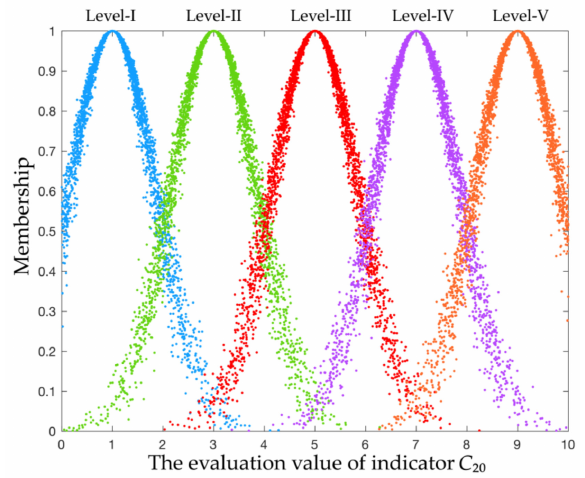
Figure 2. Hierarchical normal cloud model based on the “50% correlative degree” rule.